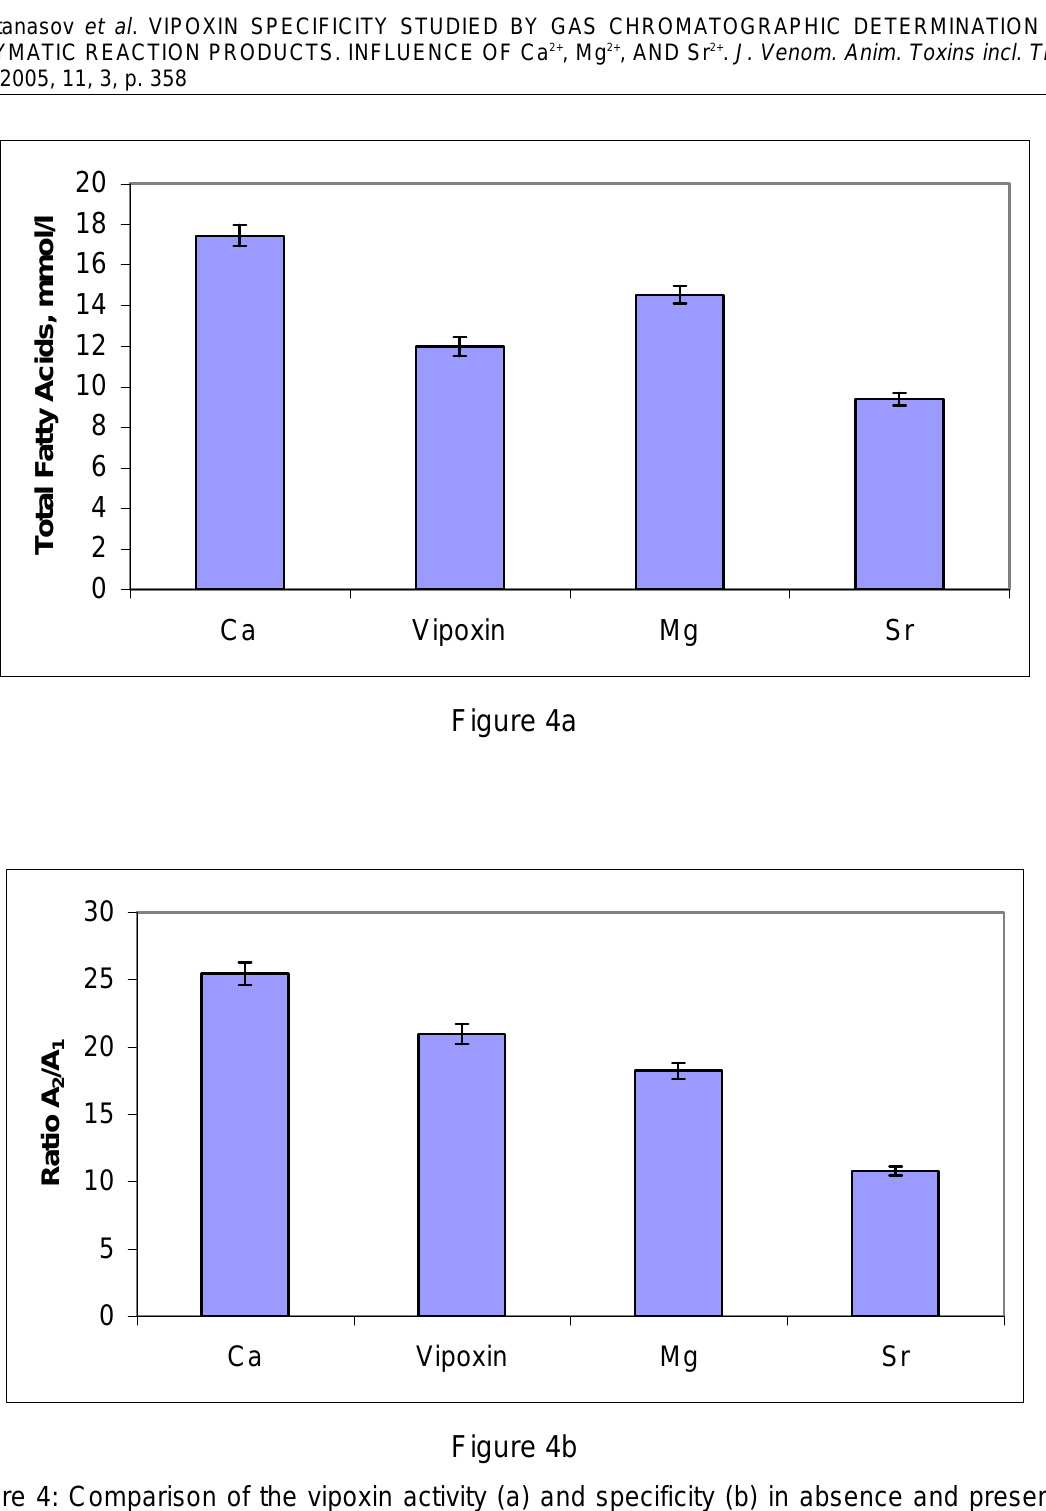
Figure 4: Comparison of the vipoxin activity (a) and specificity (b) in absence and presence of different metal ions. The marked columns represent the corresponding values in absence of metal ions. Incubation time: 25 min at the conditions described in the text. [M 2+ ] = 1.5